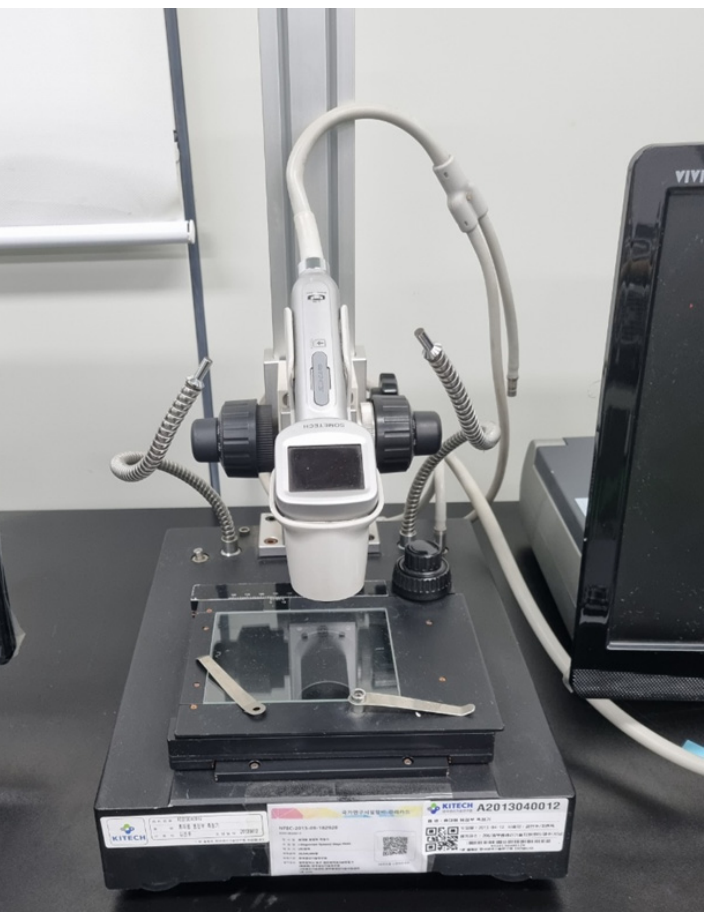
Figure 3. Optical microscope equipment.